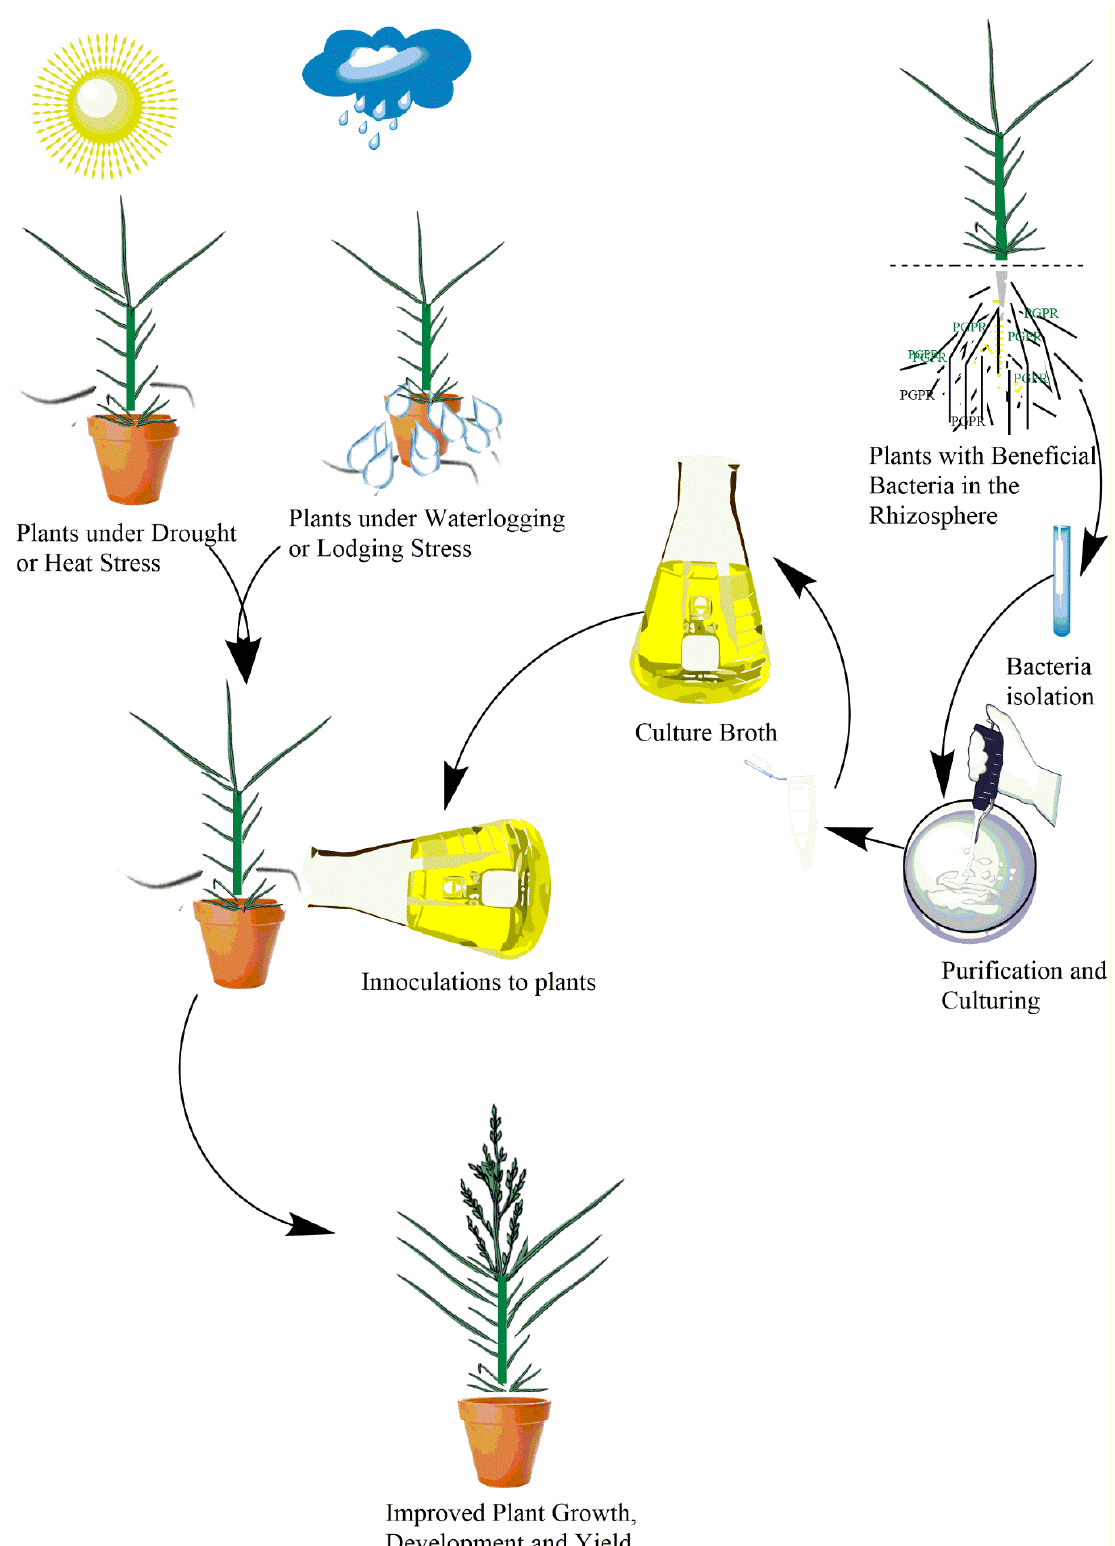
Figure 1. Potential application of PGPRs in abiotic stress mitigation and crop yield improvement in millets. PGPRs can be isolated from plants harboring the bacteria. The PGPRs are then cultured in a laboratory and applied to the soil of plant-growing